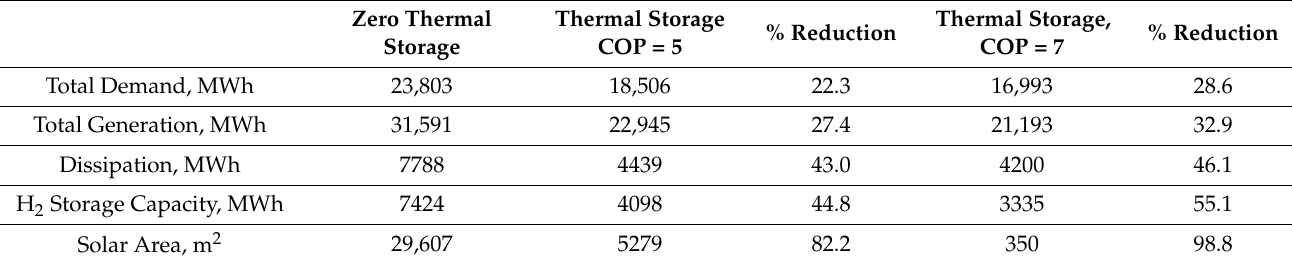
Table 3. The effect of thermal storage on key parameters for the conversion to renewable energy when two wind turbines are